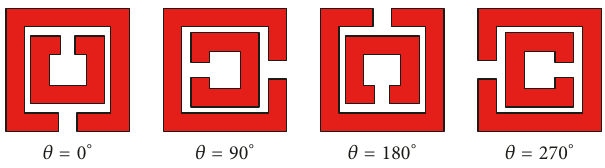
Figure 9: Deflection state of CSRR with 𝜃 changing.